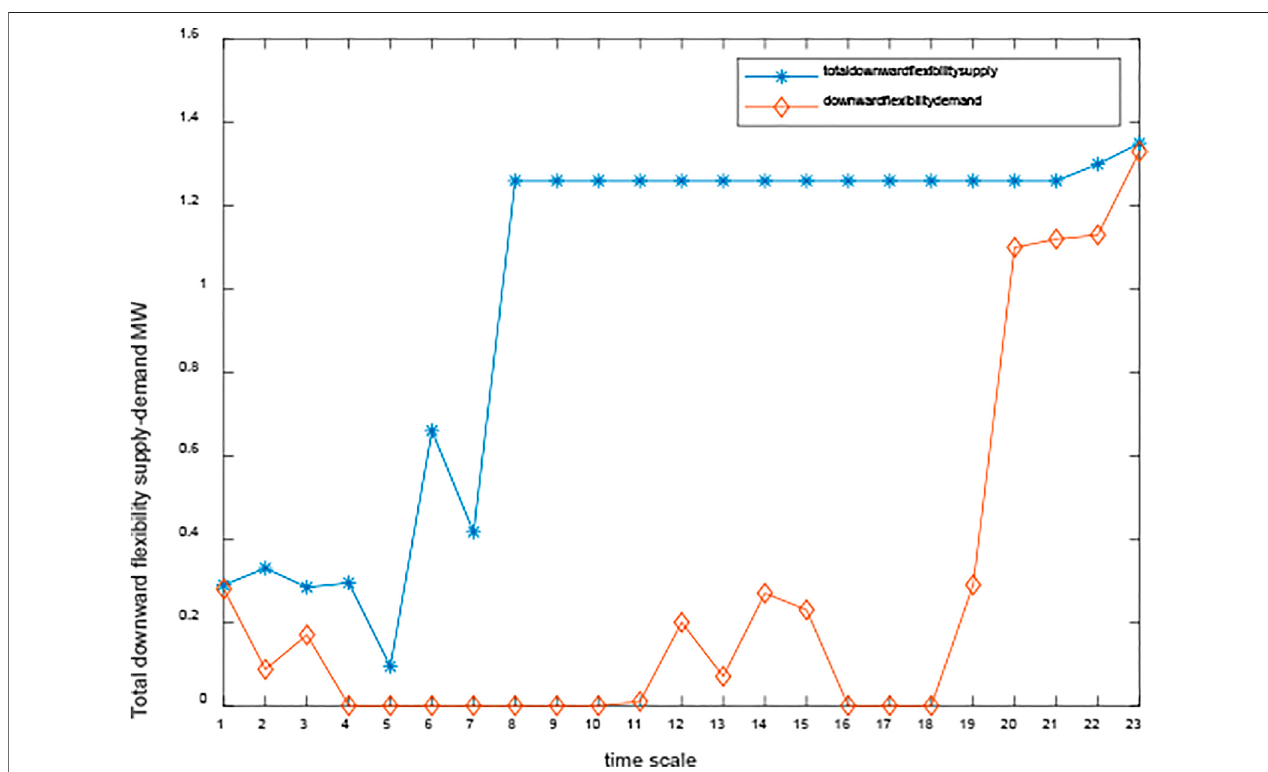
FIGURE 16 | Total downward fl exibility supply – demand of case